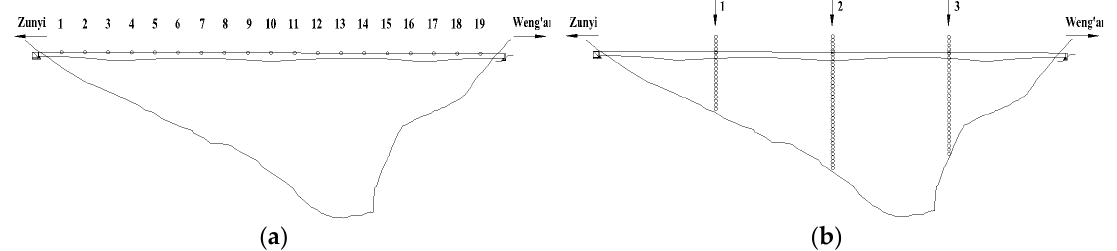
Figure 6. Schematic diagram of monitoring points. ( a ) Monitoring points at the main deck level; ( b ) Monitoring points profiles at L/4, L/2 and 3L/4 of the bridge length.